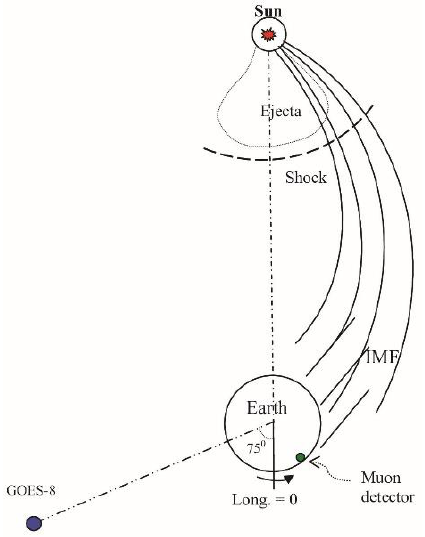
Figure 8. Schematic configuration of the relative positions of the Sun, Earth, satellite GOES-8 and L3 + C muon detector at 00:07 UT on 9th November 2000. The curved – dashed lines indicate the ejections and ejection-driven shocks. The Parker spiral field line connects the Sun to the Earth and its tangent near the Earth along a roughly 45-degree angle with the Sun – Earth line, which indicates the interplanetary magnetic field (IMF) direction. The prime meridian at Greenwich (longitude = 0) is just at the reverse direction of the Sun – Earth line.